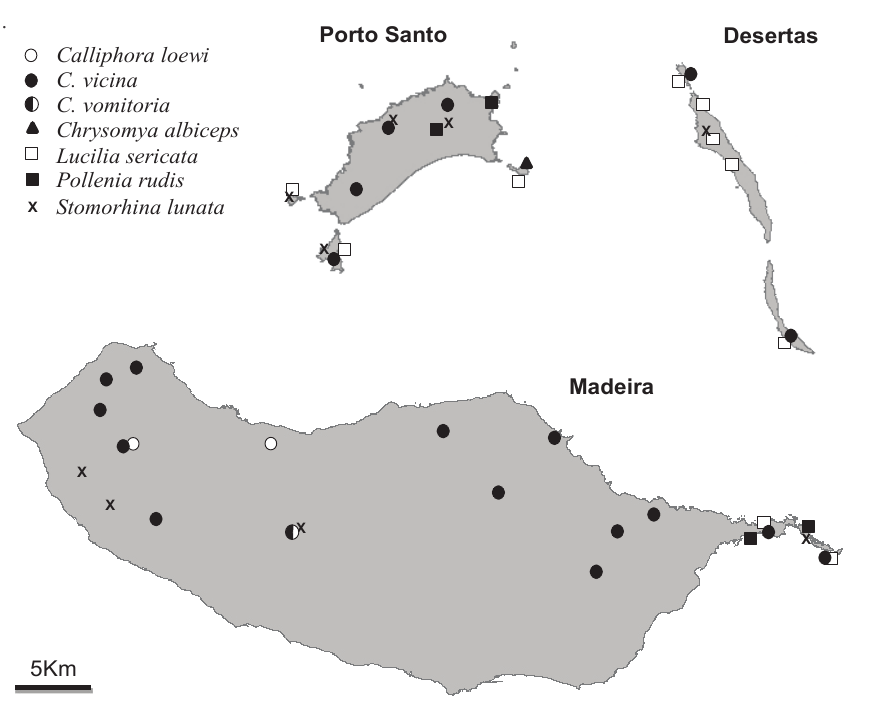
Figure 1. Blowfly records collected during the present study in the islands and islets of the Madeira Archipelago. Species records are plotted on a simplified representation of the archipelago to ease under-